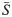
Kenyon cell degree distributions in larval D. melanogaster.(a) Distribution of number of postsynaptic partners for larval KCs. Shaded histograms: empirical distribution. Solid lines: the marginal simplex area distribution at the maximum likelihood value of α, after integrating out the number of synapses S¯ against its empirical distribution. Dotted lines: the maximum likelihood binomial distribution. (b) Lower bound for the log evidence ratio (log odds) for the fixed net weight and binomial wiring models. Positive numbers favor the fixed weight model. Evidences computed by a Laplace approximation of the marginalization over the parameters. (c) Lower bound for the log odds for the fixed net weight and bounded net weight models; positive numbers favor the fixed weight model. (d) Log likelihood of the fixed net weight model (∑ilnpA(Ki∣S¯i,α)) as a function of the scaling between synapse counts and net synaptic weights, α. (e-h) Same as (a-d) but for inputs to larval KCs.